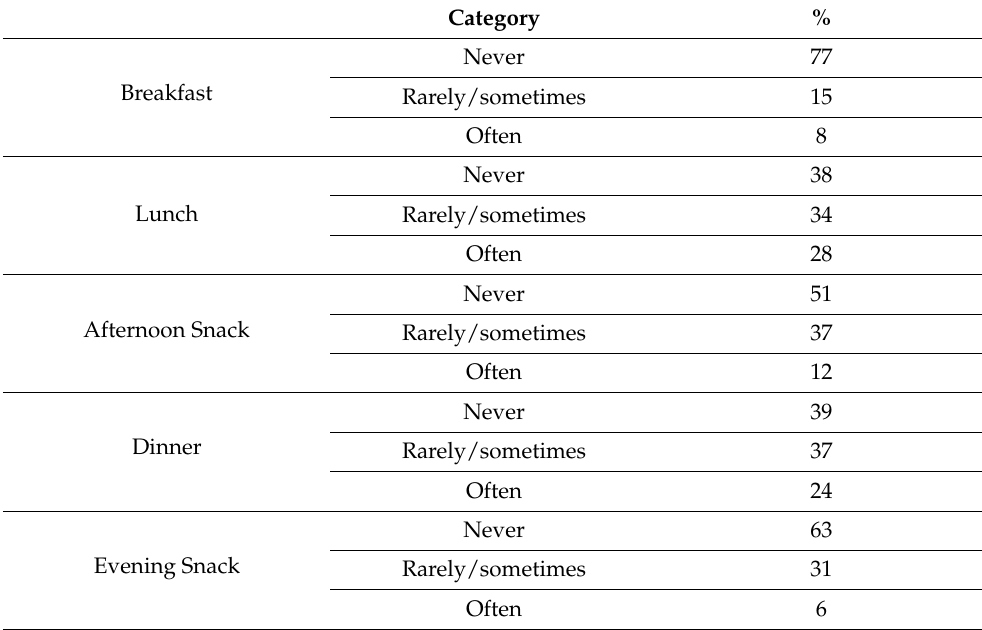
Table 2. Frequency of online order based on mealtime.